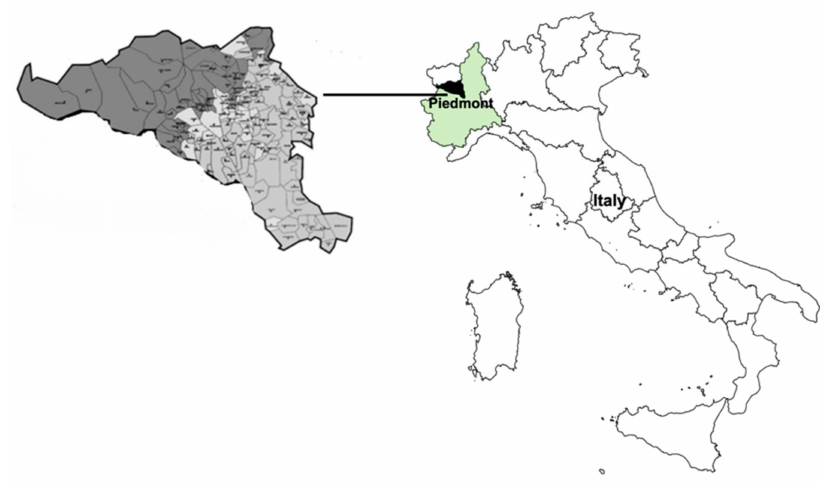
Figure 1. Study area. Canavese is located in the Piedmont region, northwest